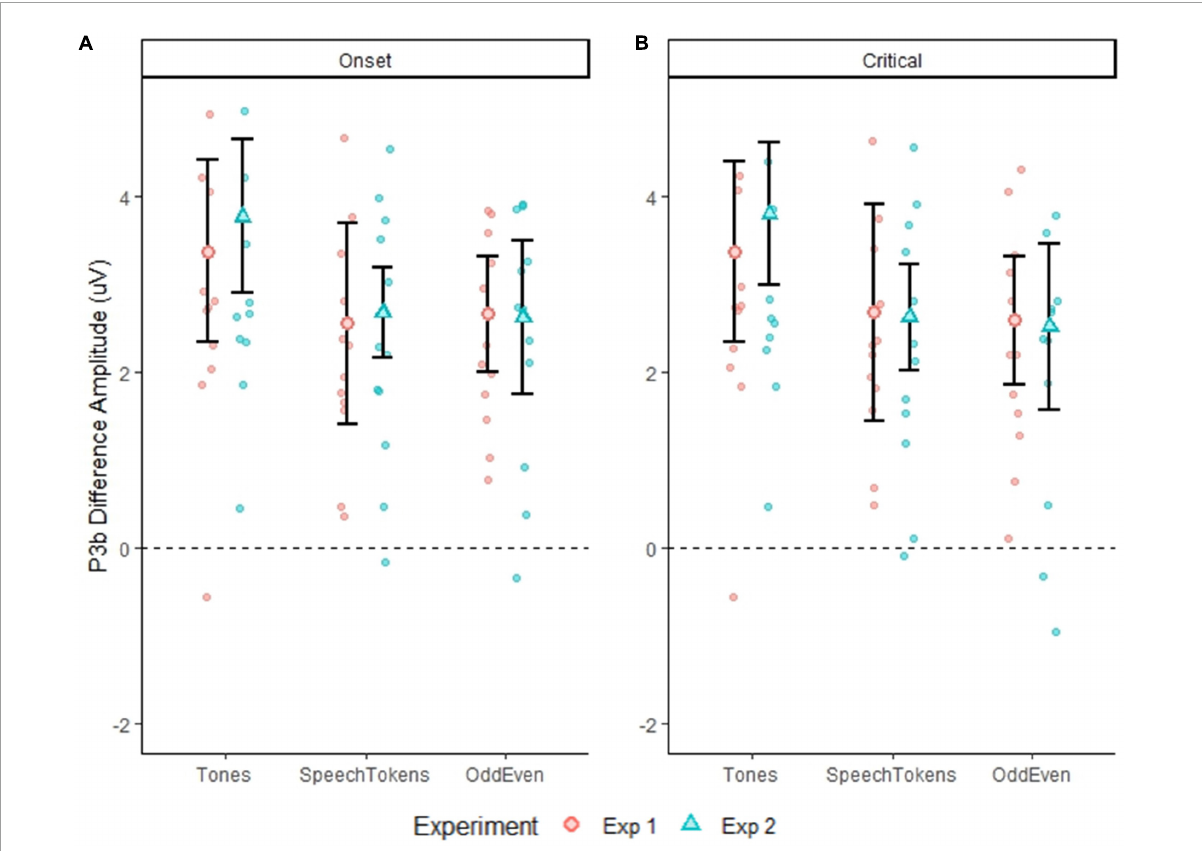
FIGURE4 Differences in P3b amplitude for both experiments for all three tasks calculated at a single trial level. Error bars represent standard error of the mean. (A) Shows the difference in the three tasks for both experiments when time locked to onset latency. (B) Shows the difference in the three tasks for both experiments when time locked to critical latency. The smaller faded red circles (Experiment 1) and smaller faded blue triangles (Experiment 2) represent the individual subject averages for each